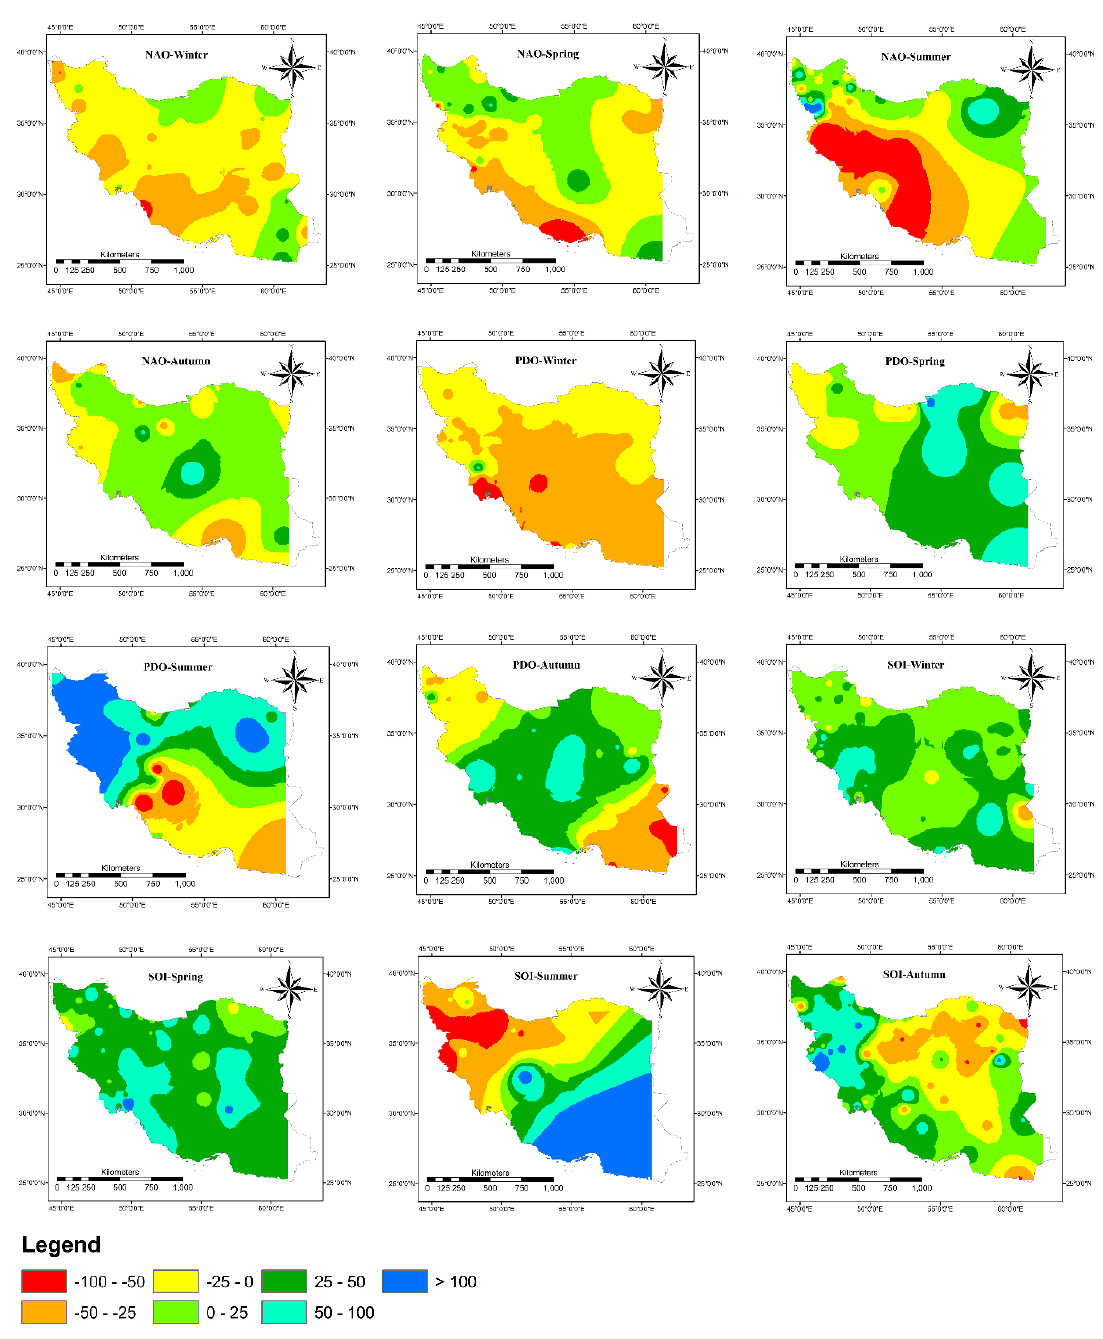
Figure 7. Total change in precipitation due to the effect of SOI, NAO, and PDO in the range of − 2 < x < − 1, where x denotes the SOI, NAO, and PDO value.